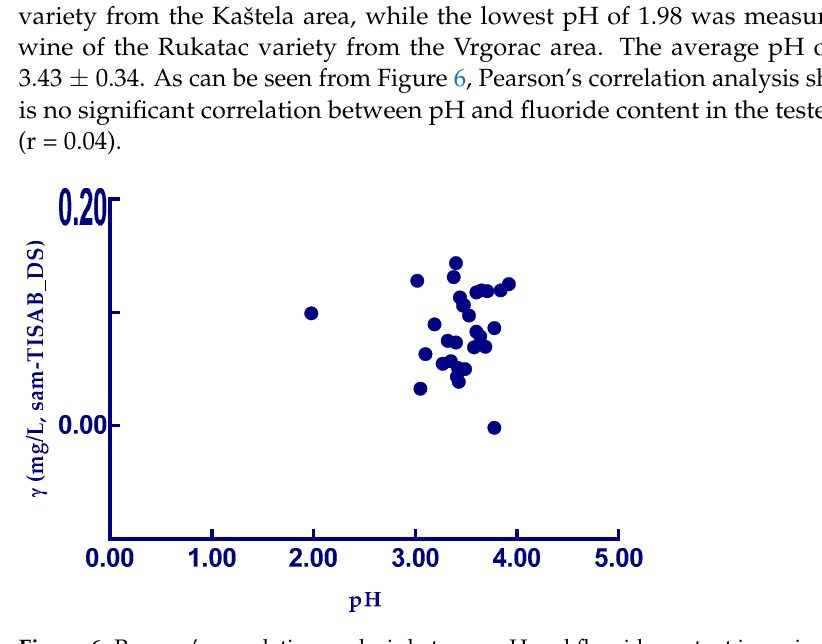
Figure 6. Pearson’s correlation analysis between pH and fluoride content in various kinds of a tested white and red wines in the dependence of sam-TISAB_DC and pH.